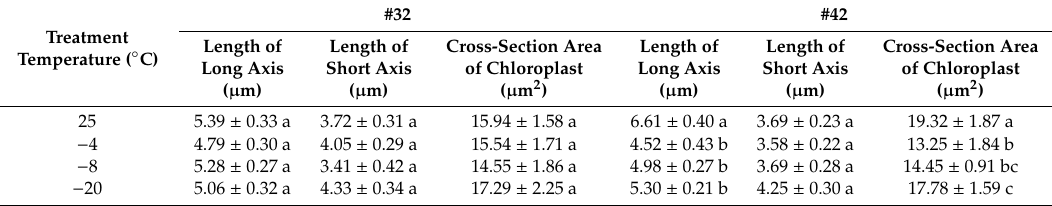
Table 4. E ff ects of low temperature on cross sections of chloroplasts in two clones. Treatment Temperature ( ◦